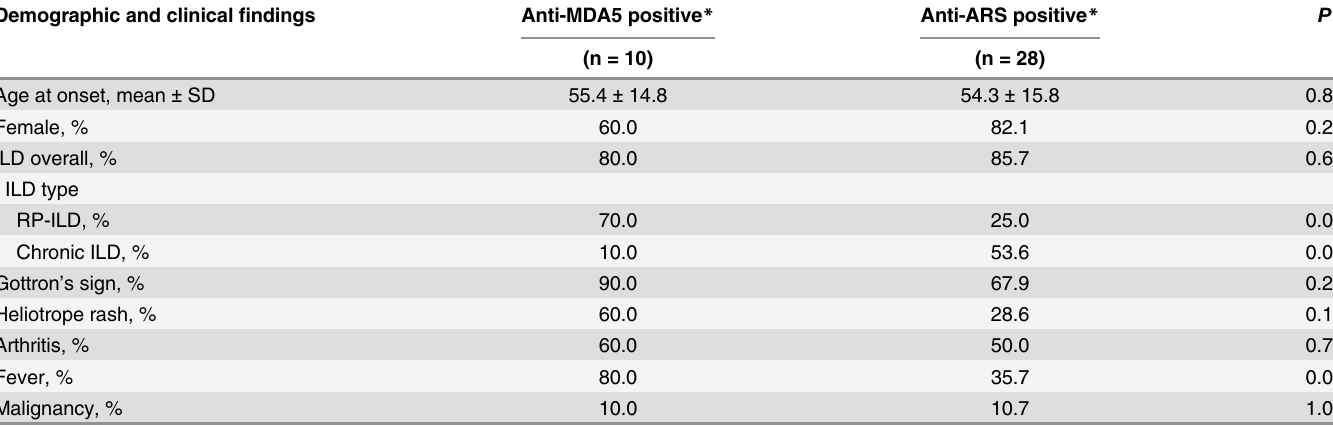
* Two patients who were positive for both anti-MDA5 and anti-ARS by ELISA, but were negative for anti-ARS by IP assay were included in the anti- MDA5-positive